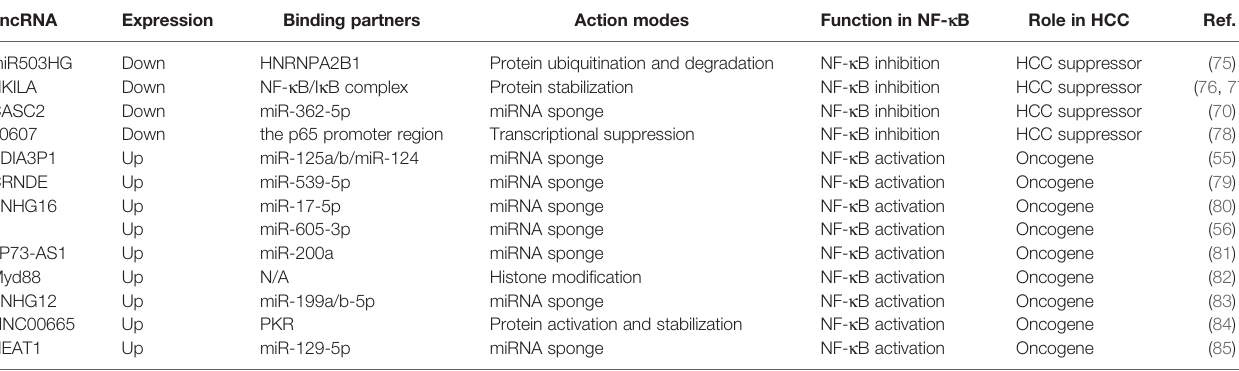
TABLE 2 | LncRNAs involved in the regulation of NF- k B pathway and/or NF- k B activity in HCC.